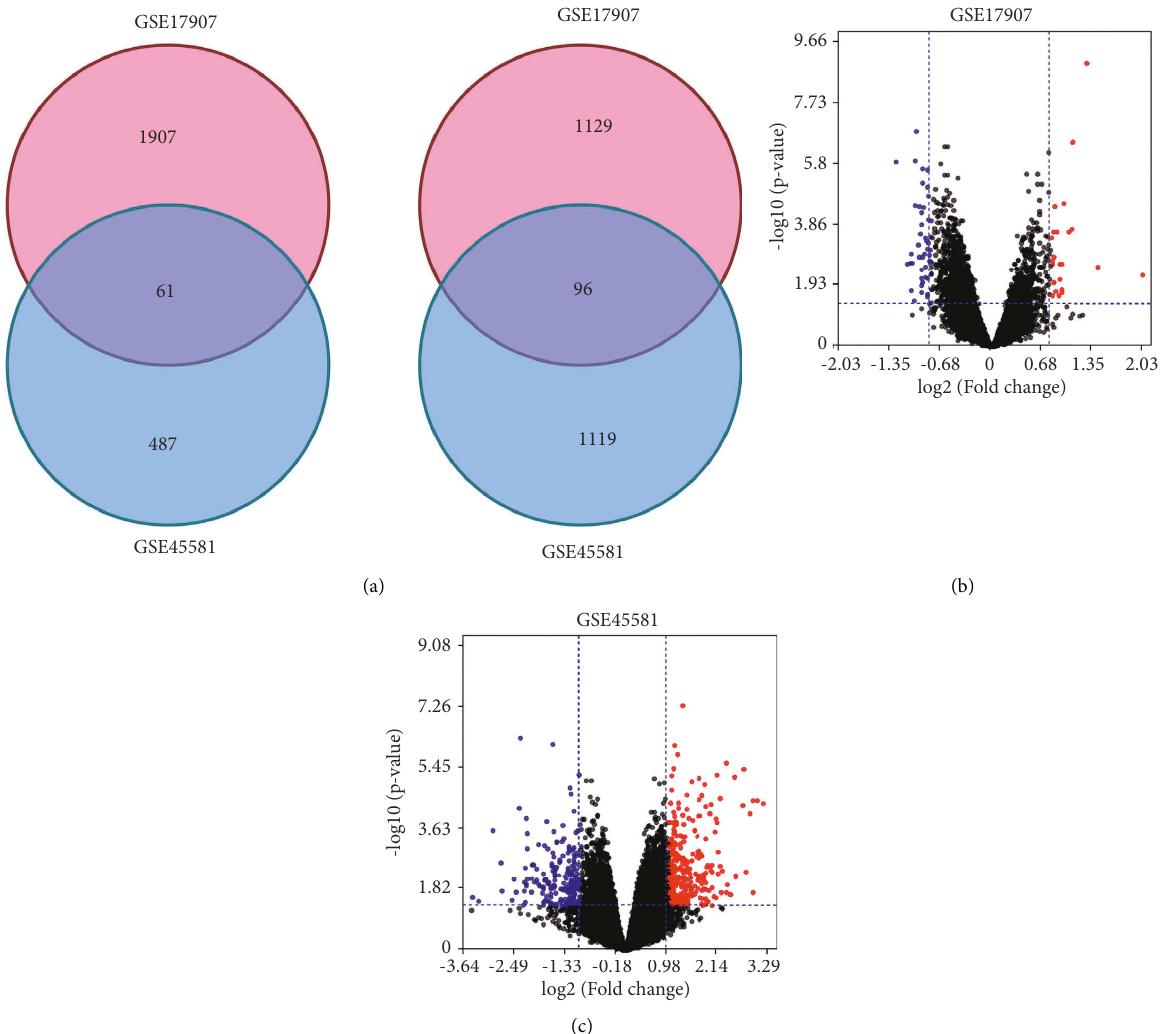
Figure 1: Identification of the DEGs from two IBC microarrays. (a) Venn diagram of 157 overlap DEGs analyzed in two GEO datasets. Volcano plot of gene expression between IBC and non-IBC tissues in GSE45581 (b) and GSE17907 (c). Red dots indicated significantly upregulated genes in IBC; blue dots indicated significantly downregulated genes in IBC; black dots indicated nondifferentially expressed genes. P < 0 . 05 were considered as